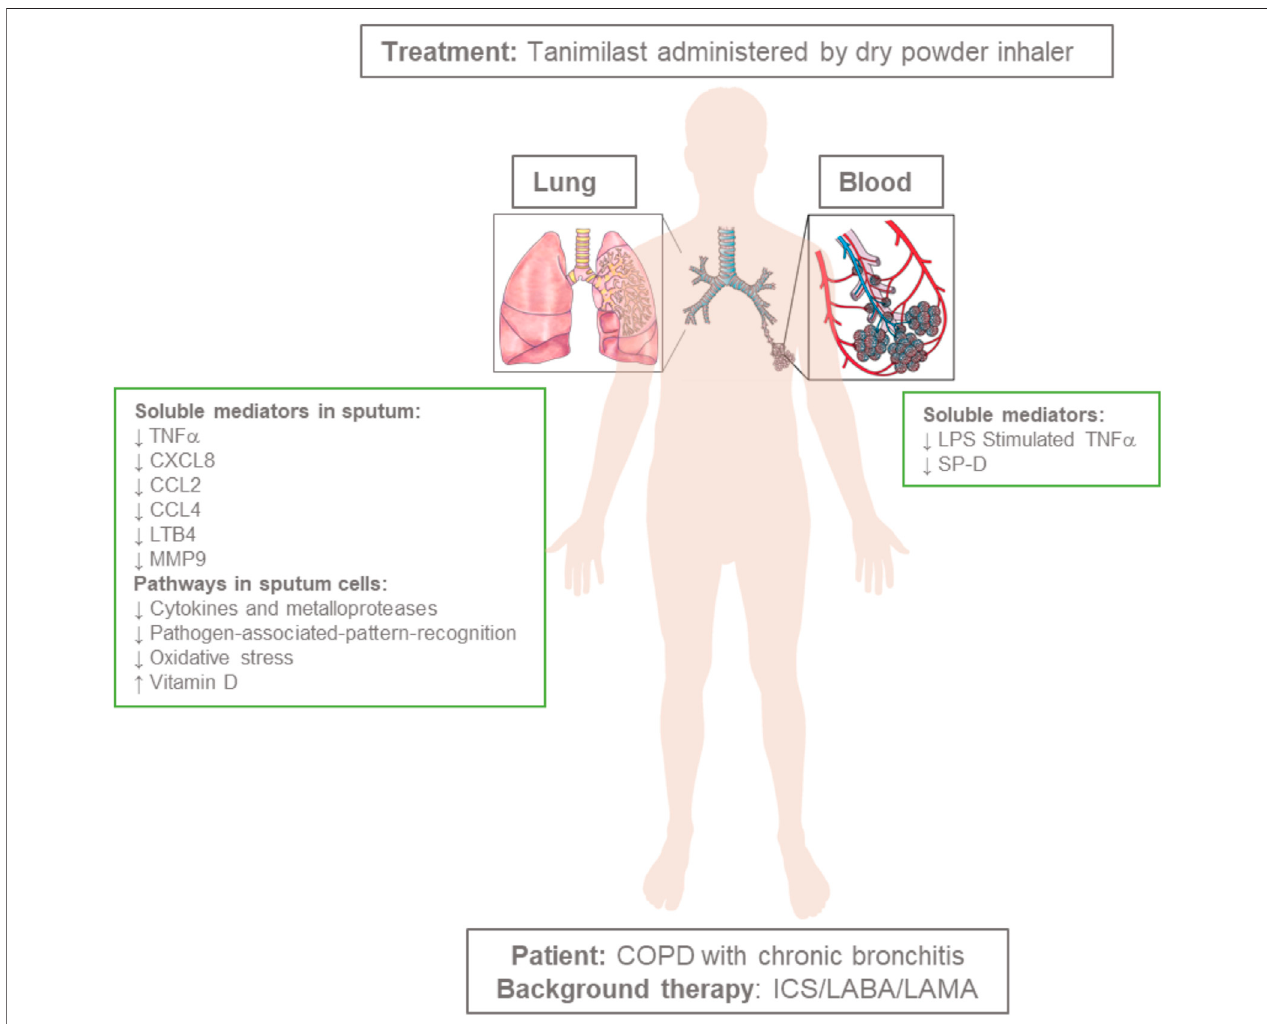
FIGURE 2 | Administration of tanimilast (total daily doses of 1,600 or 3,200 μ g) to COPD patients with a chronic bronchitis phenotype on top of inhaled triple therapy(ICS,LABAandLAMA)resultsinabroadanti-in fl ammatorypro fi